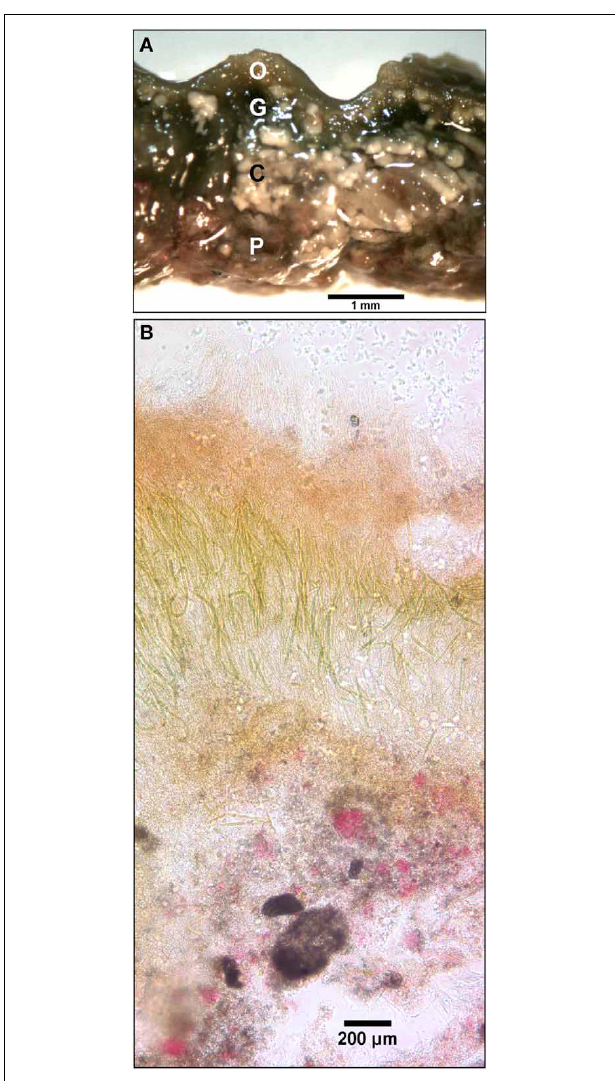
FIGURE 3 | Ultrastructure of the Hot Lake mat sampled on September 1, 2011. (A) Cross-section of the Hot Lake mat at the millimeter scale. Orange (O), green (G), and pink (P) lamina are readily apparent along with interspersed carbonate minerals (C). (B) Ultrastructure of a 50 μ m-thick section of the Hot Lake mat (100X magnification).